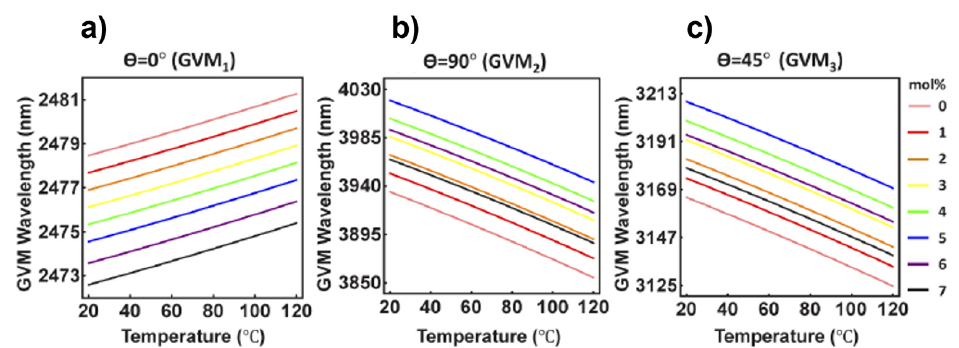
Figure 8. GVM wavelengths of MgLN with different doping ratio as a function of the temperature, for tilt angles Θ = 0° ( a ), Θ = 90° ( b ) and Θ = 45° ( c ). Reproduced with permission from [57], copyright 2021.